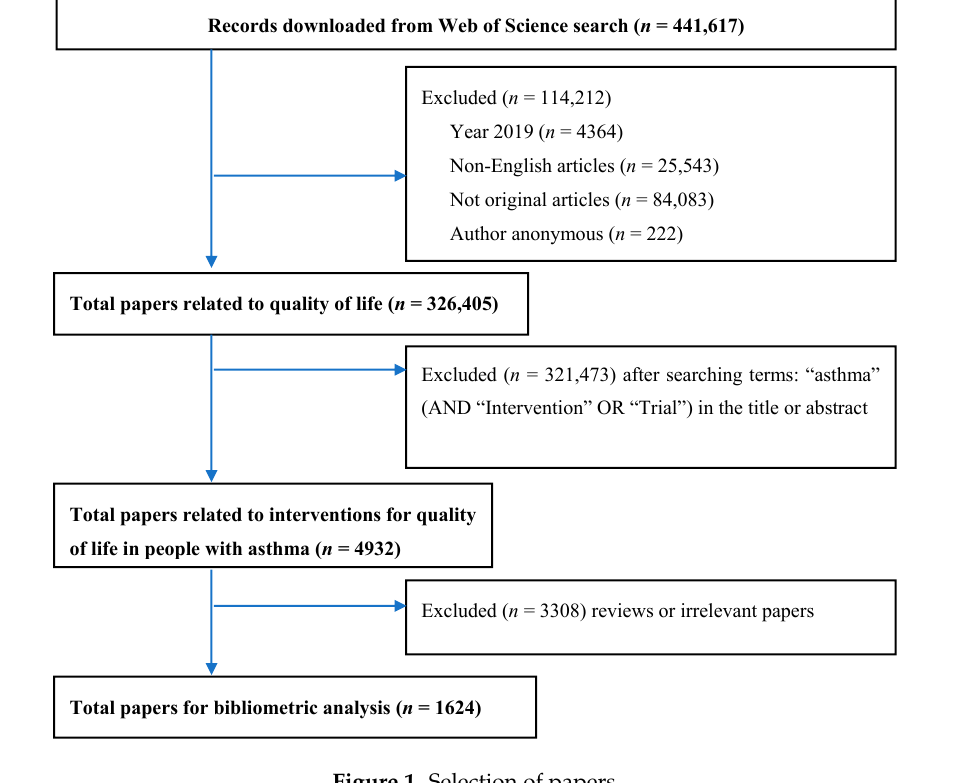
Table 2. General characteristics of